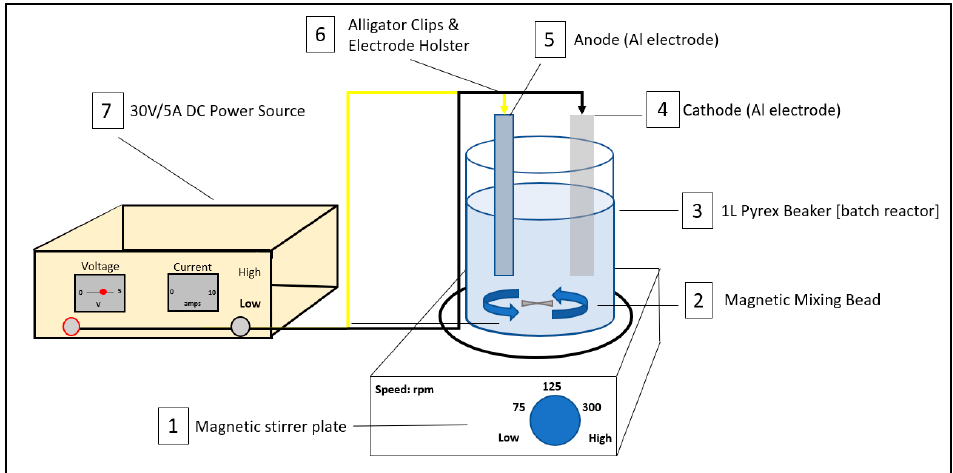
Figure 1. Batch electro-coagulation experimental setup.